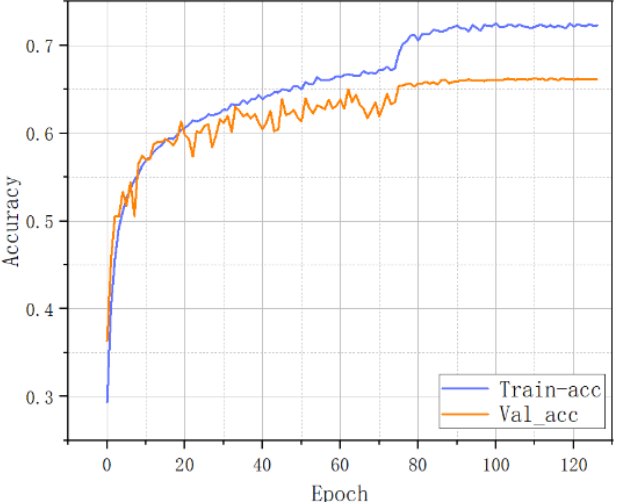
Figure 13. Accuracy curve.